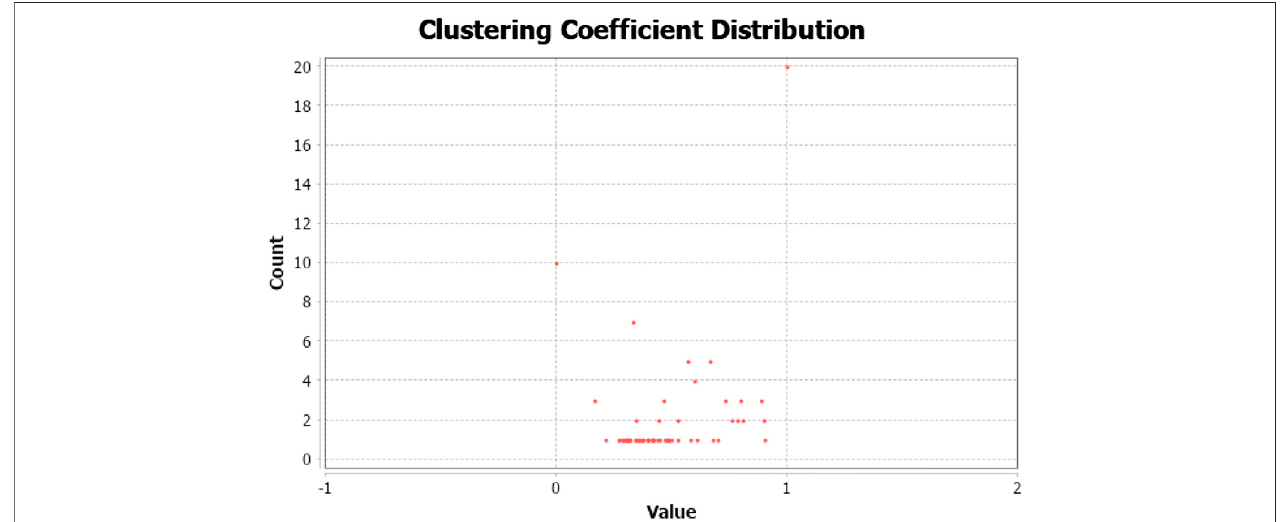
FIGURE3| Theclusteringcoef fi cientdistributionoftheglobalnetwork.Note: Figure3 representsthedistributionofclusteringcoef fi cientsinvariouscountries.The verticalandhorizontalaxesofeachsubplotarenodecountsandparameterdistributionvalues,respectively.Thehorizontalaxisrepresentstheclusteringcoef fi cientvalue of each country. The vertical axis represents the number of countries.